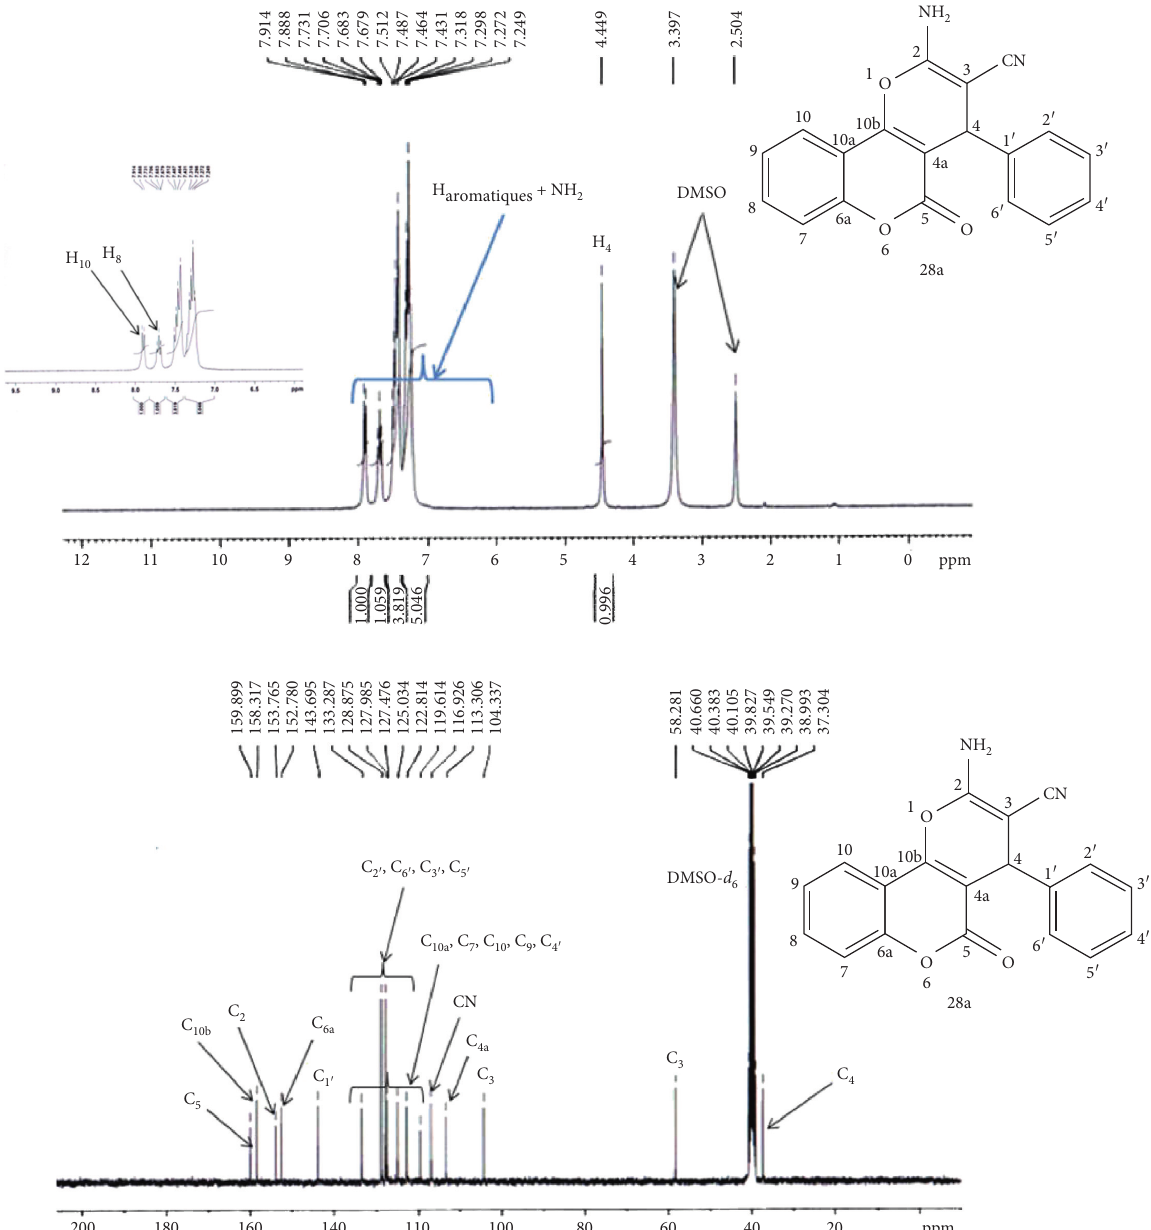
Figure 10: Experimental 1 H-NMR and 13 C-NMR chemical shift spectra of the Chrom-D compound. The atom numbering is given in the same